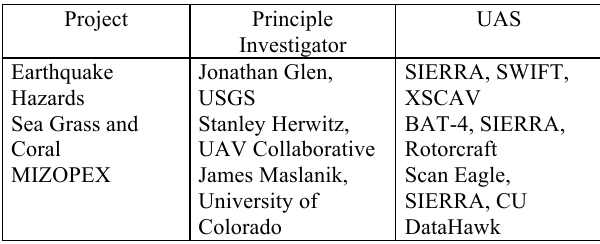
Table 2. UAS-Enabled Earth Science Projects